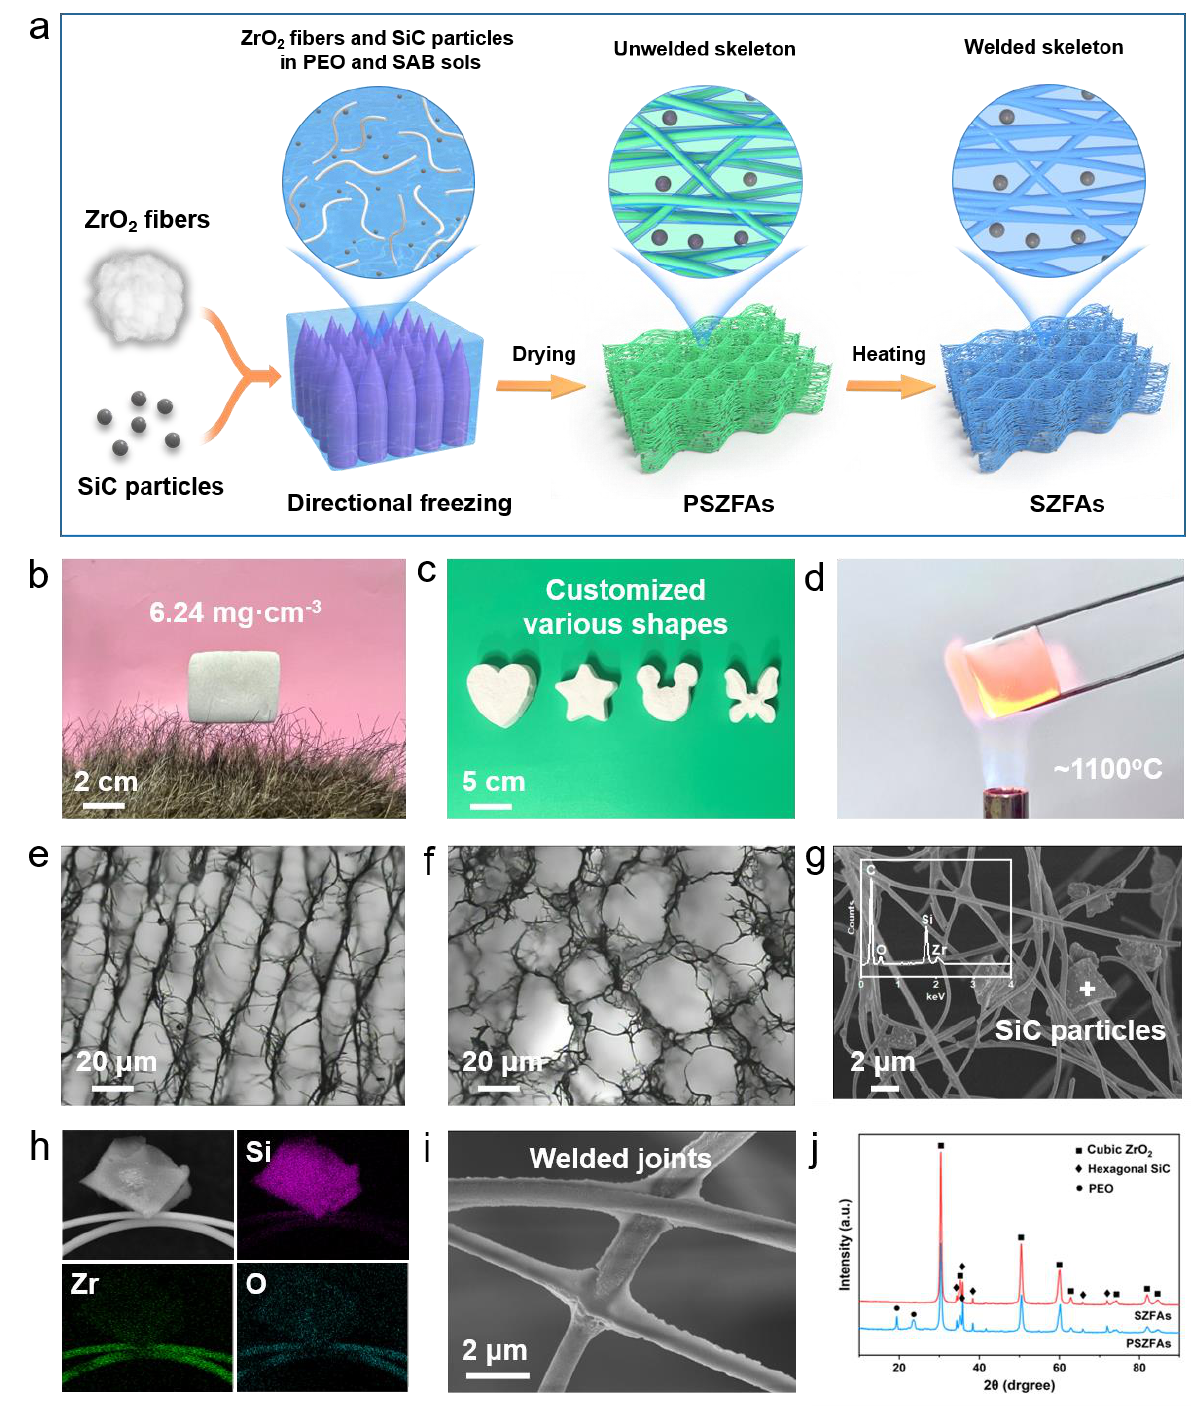
Figure 4. ( a ) Schematic diagram of the preparation process of SZFAs. ( b ) Macroscopic photograph of SZFAs standing on artificial hairs. ( c ) Customized SZFAs with different shapes. ( d ) SZFAs heated by 1100 °C flame without damage. Microscopic photographs of SZFAs in ( e ) radial and ( f ) axial directions. ( g ) SEM image of SZFAs and EDS pattern of SiC particles. ( h ) EDS mapping images of Si, Zr and O elements in SZFAs. ( i ) SEM image of inter-fiber welded joints. ( j ) XRD patterns of PSZFAs and SZFAs.